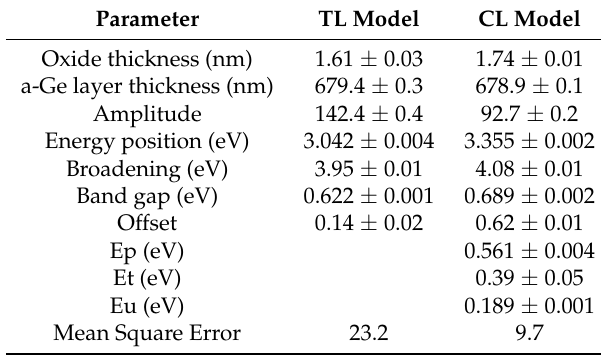
Table 1. Fitted parameters of both parametric models for the ia-Ge